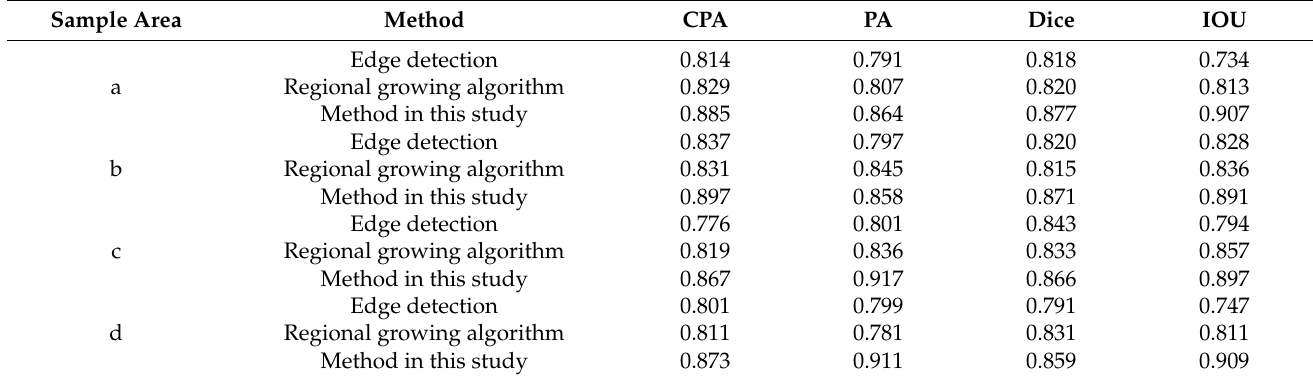
Table 3. Comparison of accuracy evaluation index values of different